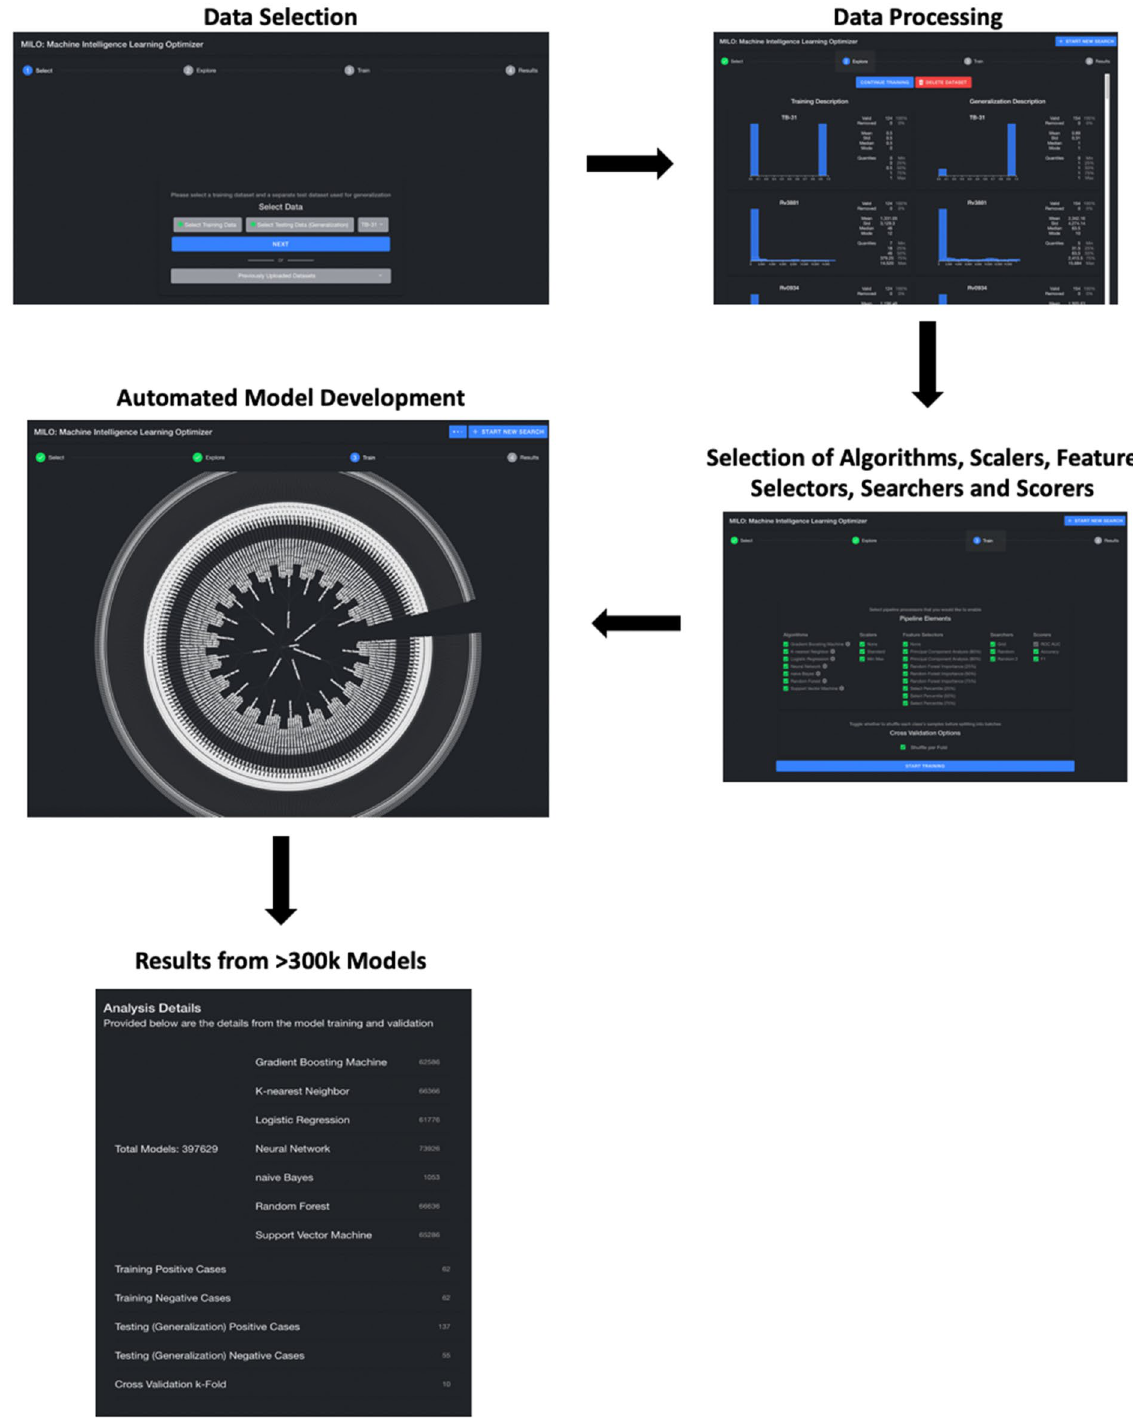
Figure 2. User interface for MILO. Stepwise overview of the user-friendly interface for the automated-machine learning platform MILO sequentially through the pipeline: data upload, data processing, selection of algorithms, scalers, feature selectors, searchers, and scorers, and assessment of model results from generalization